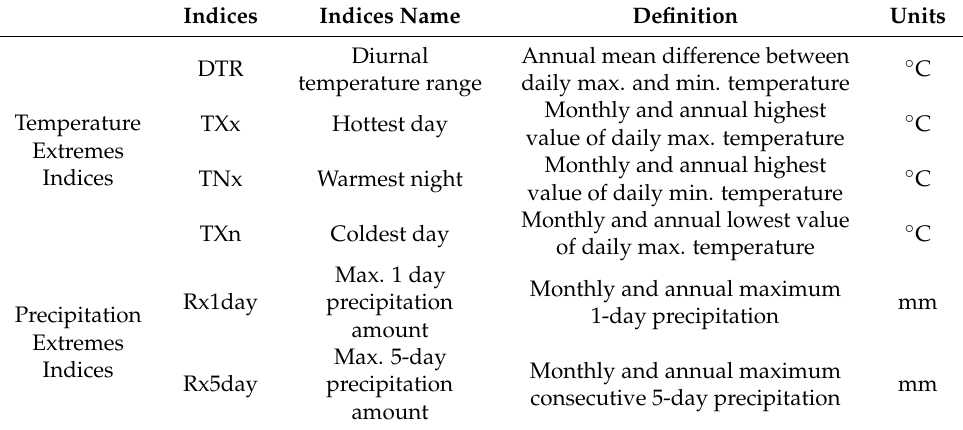
Table 1. Climate extremes indices used in this